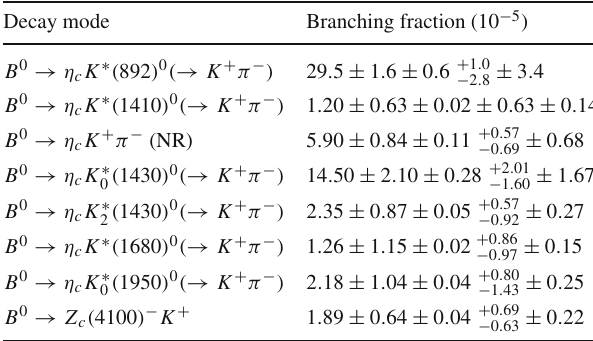
Table 8 Branching fraction results. The four quoted uncertainties are statistical, B 0 → η c K + π − branching fraction systematic (not includ- ing the contribution from the uncertainty associated to the efficiency ratio, to avoid double counting the systematic uncertainty associated to the evaluation of the efficiencies), fit fraction systematic and external branching fractions uncertainties, respectively Decay